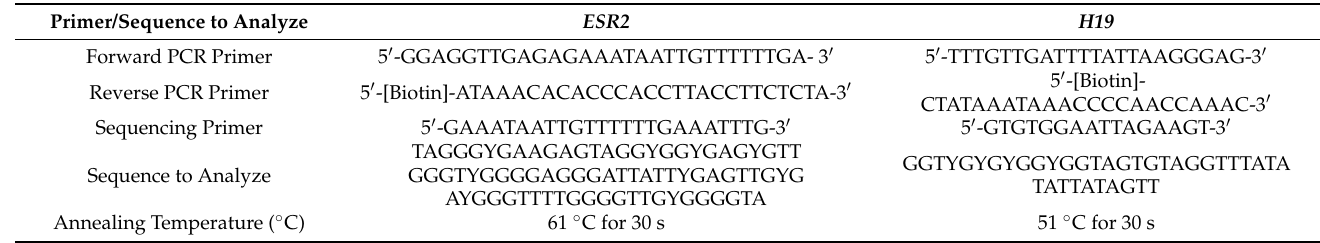
Table 1. DNA methylation primer sequences and PCR cycling